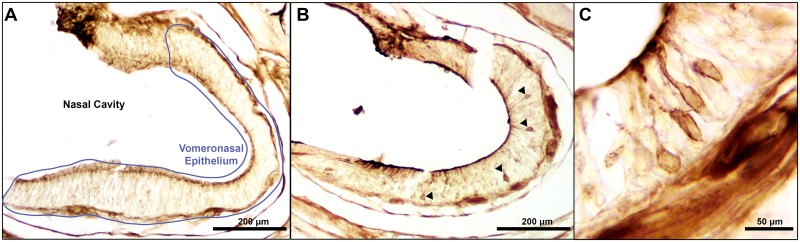
AGB immunohistochemistry.Transverse cross-sections of the olfactory chamber comparing the vomeronasal epithelium from females treated with 0.5X PBS (A) and WE (B), with arrows pointing to the cell bodies of immunoreactive neurons. (C) Higher magnification of four AGB neurons in close proximity. For greater detail on the architecture of the plethodontid olfactory system, see Wirsig-Wiechmann et al. [24].